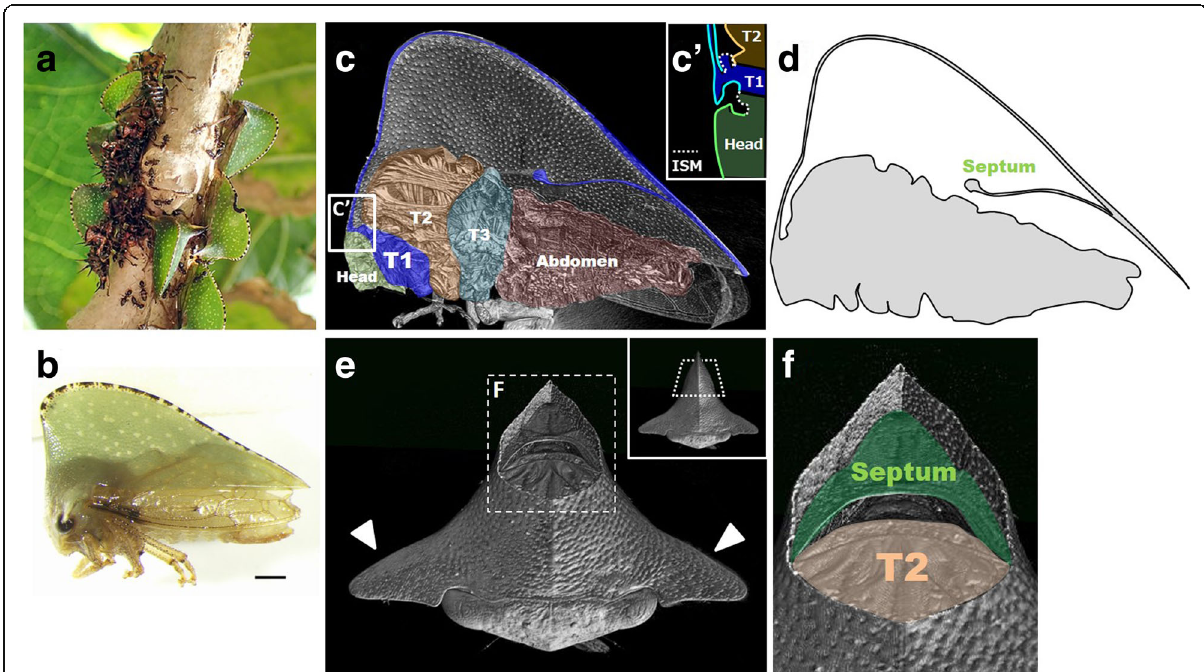
Fig. 2 Adult morphology of focal species, Antianthe expansa. a Adults and nymphs of Antianthe expansa in the field. Adults and various nymphal instars are present on the same branch and are often associated with ants. b Side view of adult. Scale bar indicates 1 mm. c Virtual sagittal section of adult via micro-CT scan imaging. Head, prothorax (T1), mesothorax (T2), metathorax (T3) and abdomen are indicated in different colors. Connection point of head, helmet (dorsal prothorax), and mesothorax is magnified in C ’ . ISM: intersegmental membrane. d Diagram of cross section of C. It can be clearly seen that the helmet is a thin structure and connects only at the most anterior region. e Frontal view of adult via micro-CT imaging. The dorsalmost region of the helmet was graphically excised to show the inner side of the helmet. White arrows indicate a pair of lateral projections (humeral horns). f Magnified image of dashed window in E. Highlighted in green is the septum and in orange is dorsal part of the mesothorax